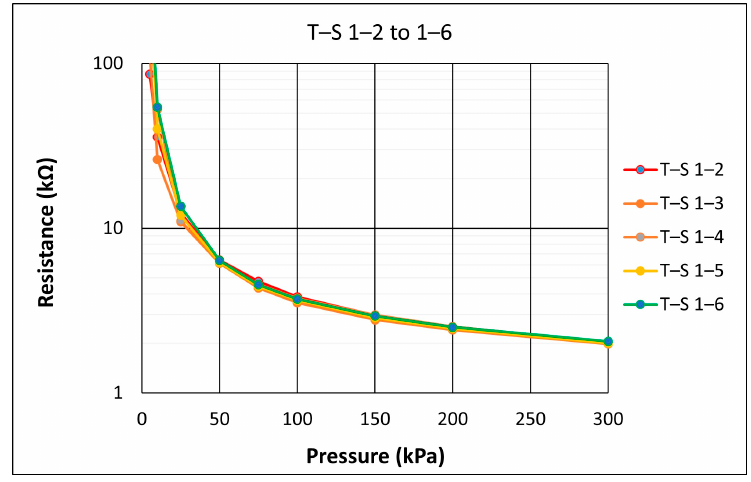
Figure 10. An example of a pressure vs. resistance repeatability test graph carried out on one QTSS™ sensel.